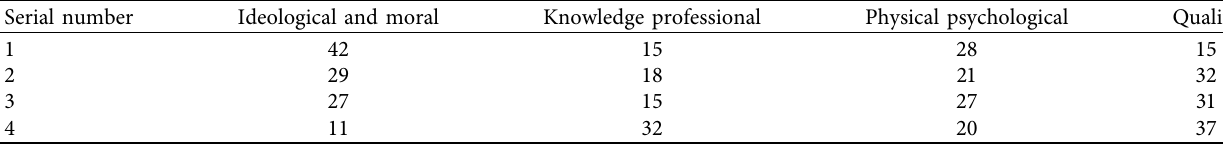
Table 6: Statistical table of first-class index survey data.